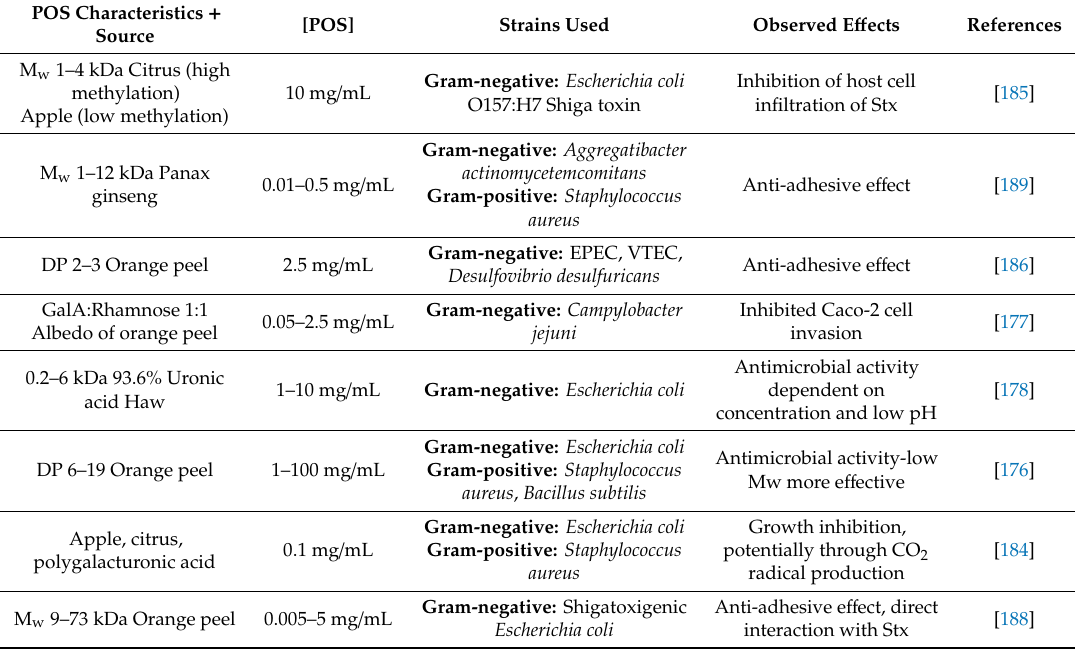
Table 7. Overview of the anti-pathogenic functionalities of